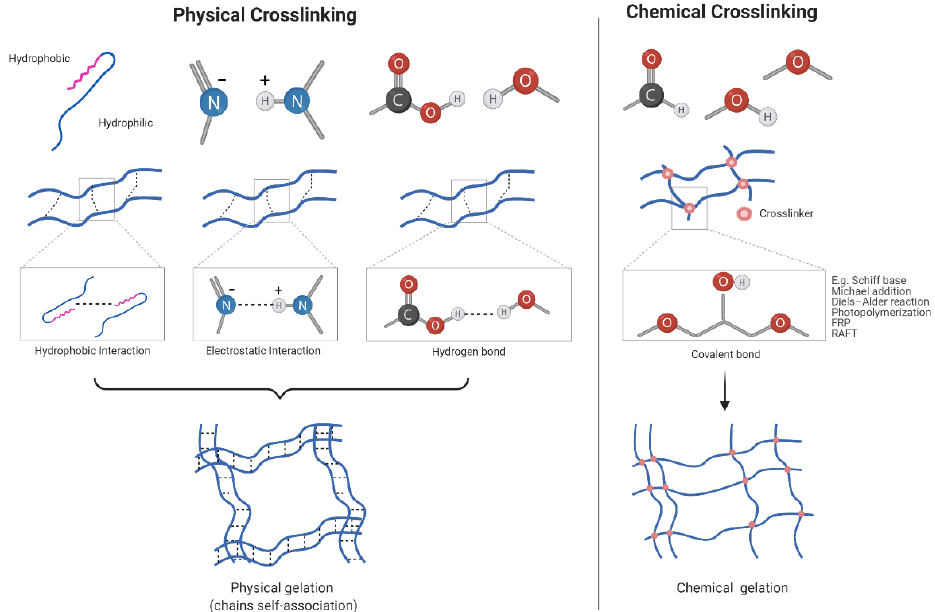
Figure 1. Schematic representation of hydrogels formation via chemical and physical crosslinking. RAFT—reversible addition-fragmentation chain transfer polymerization, FRP—free radical poly- merization. O—oxygen, N—Nitrogen, C—Carbon, H—Hydrogen. Created with BioRender.com (accessed on 15 January